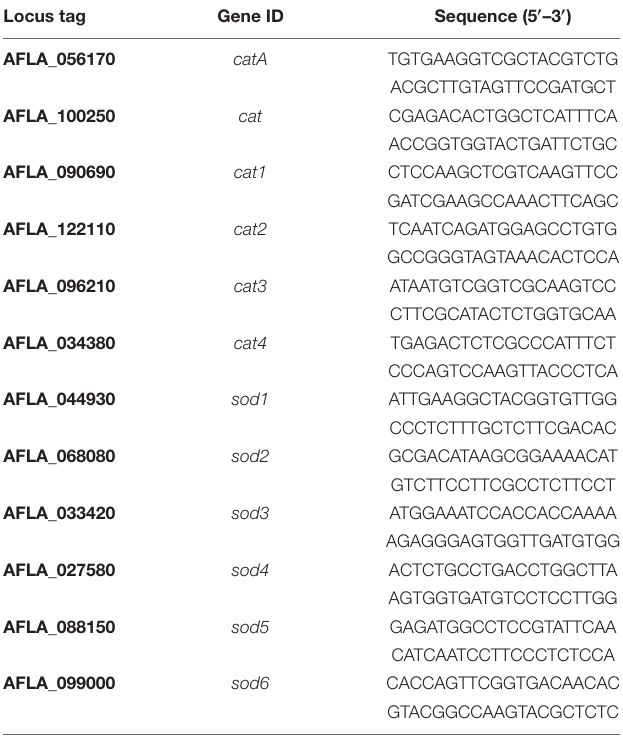
TABLE 1 | Primers used in this study. Locus